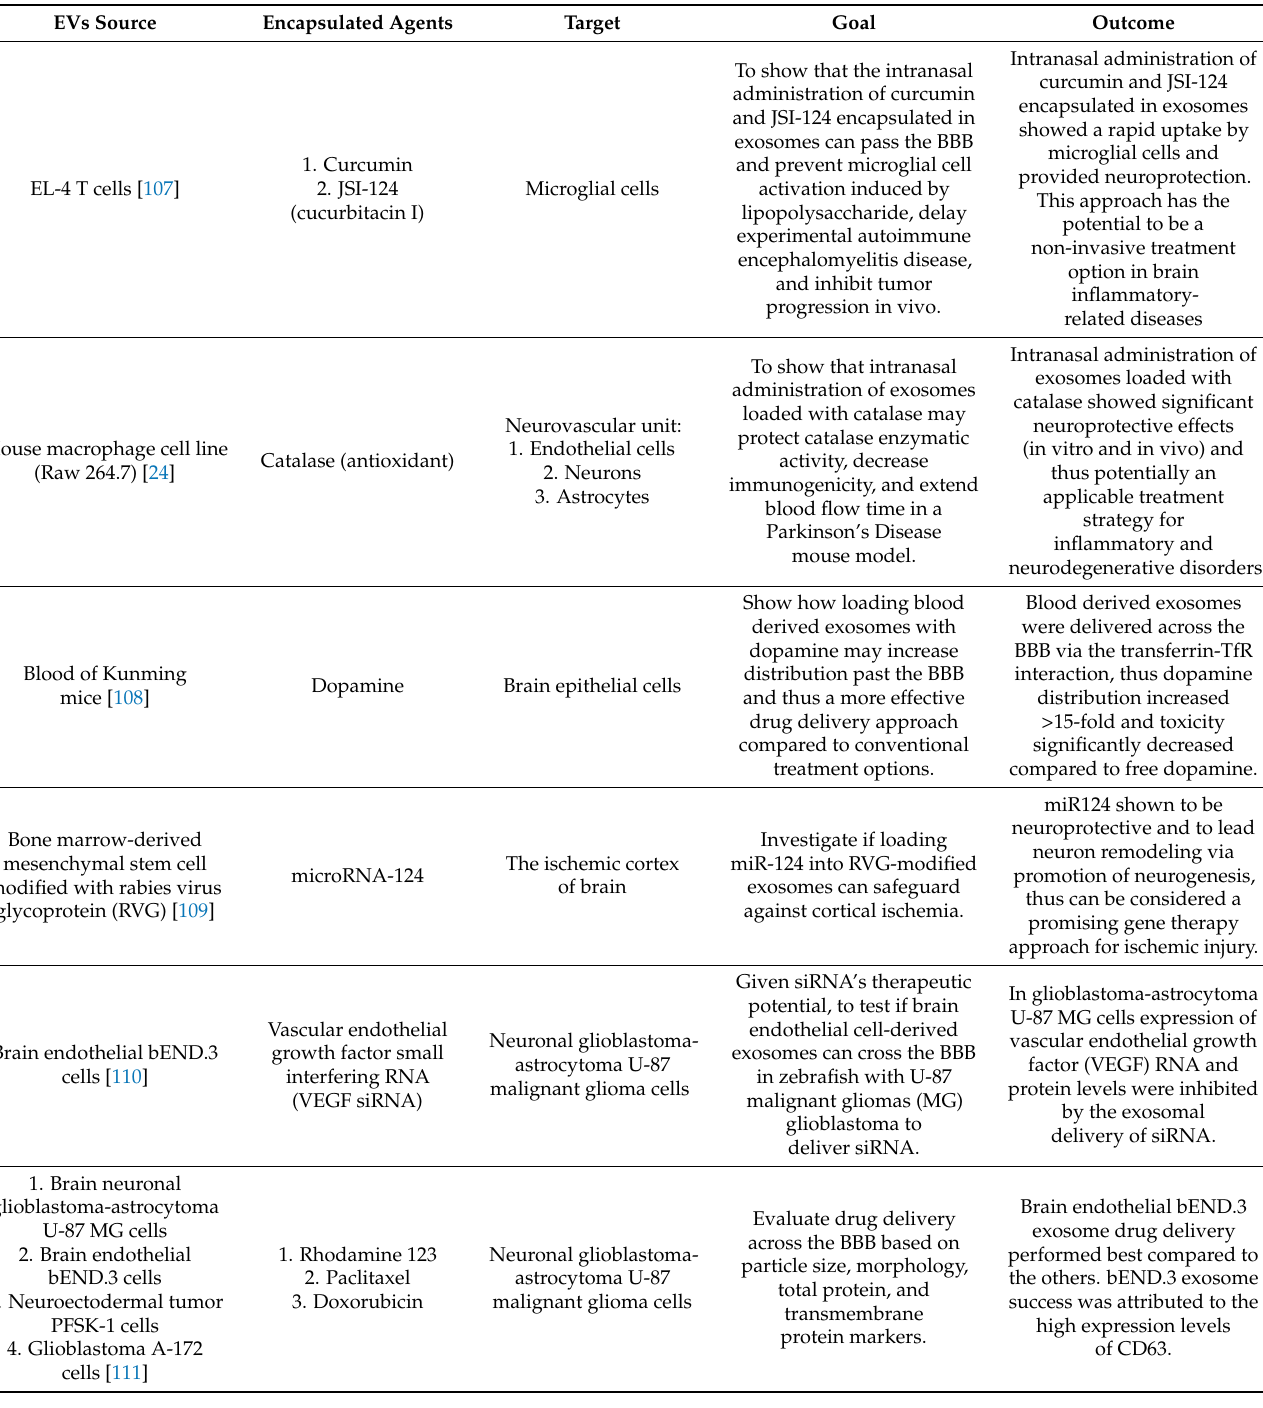
Table 2. EVs drug delivery systems in CNS